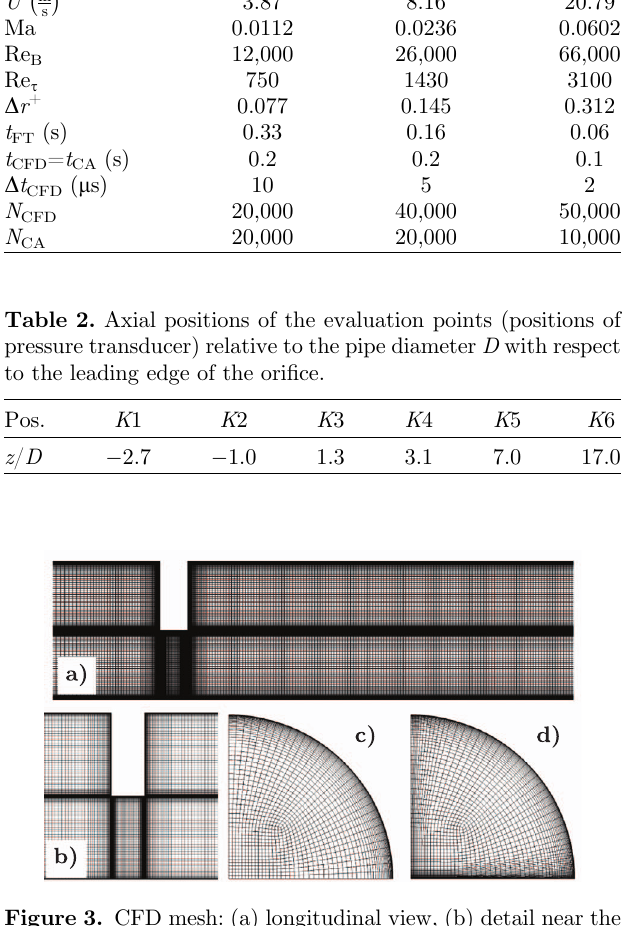
Figure 3. CFD mesh: (a) longitudinal view, (b) detail near the ori fi ce, (c) cross-sectional view of the in- and out fl ow section and (d) cross-sectional view of the re fi ned mesh near the ori fi